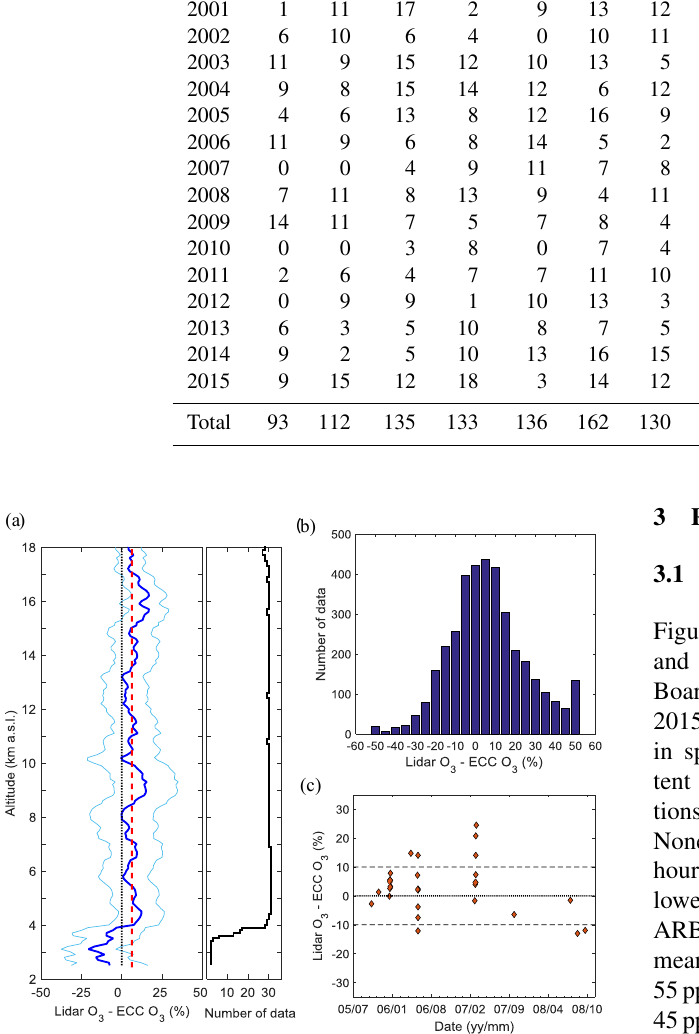
Figure 1. (a) Profile of the mean relative difference between the lidar and the ECC ozone number density for the 32 simultaneous measurements (dark blue). Lidar uncertainty (light blue) and mean relative difference obtained between 4 and 16km (red dotted line) are superimposed. The black solid curve shows the number of data points at each altitude. (b) Histogram of the difference between the lidar and the ECC ozone number density. (c) Column-averaged (be- low 8km) difference between the lidar and the ECC sonde for each